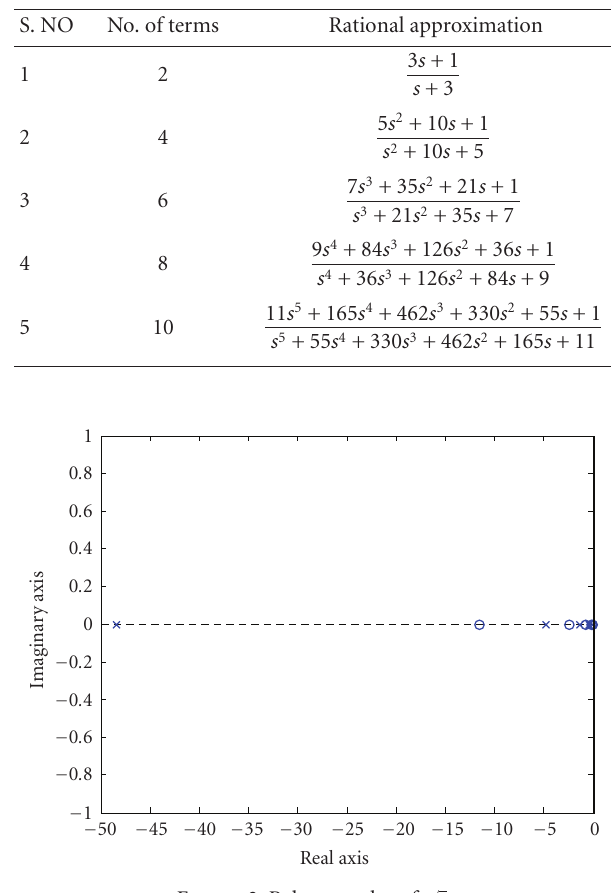
Figure 1: Comparison of magnitude and phase responses of rational approximation functions with ideal